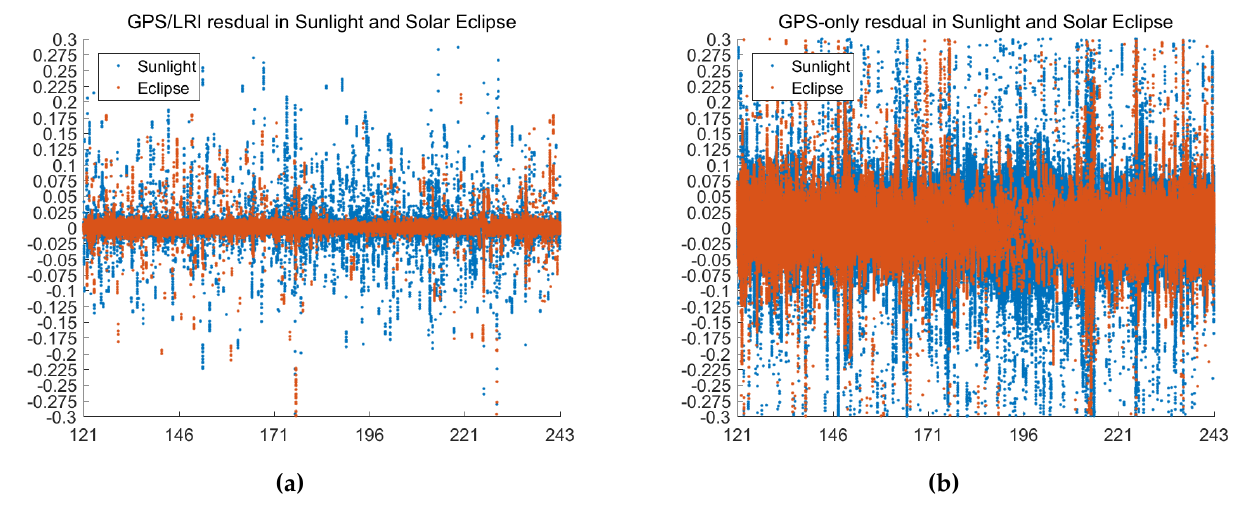
Figure 20. Days 121–242 KBR residuals (unit: m) for the GPS/LRI ( a ) and GPS-only ( b ) relative orbit in the Sunlight and Solar eclipse).